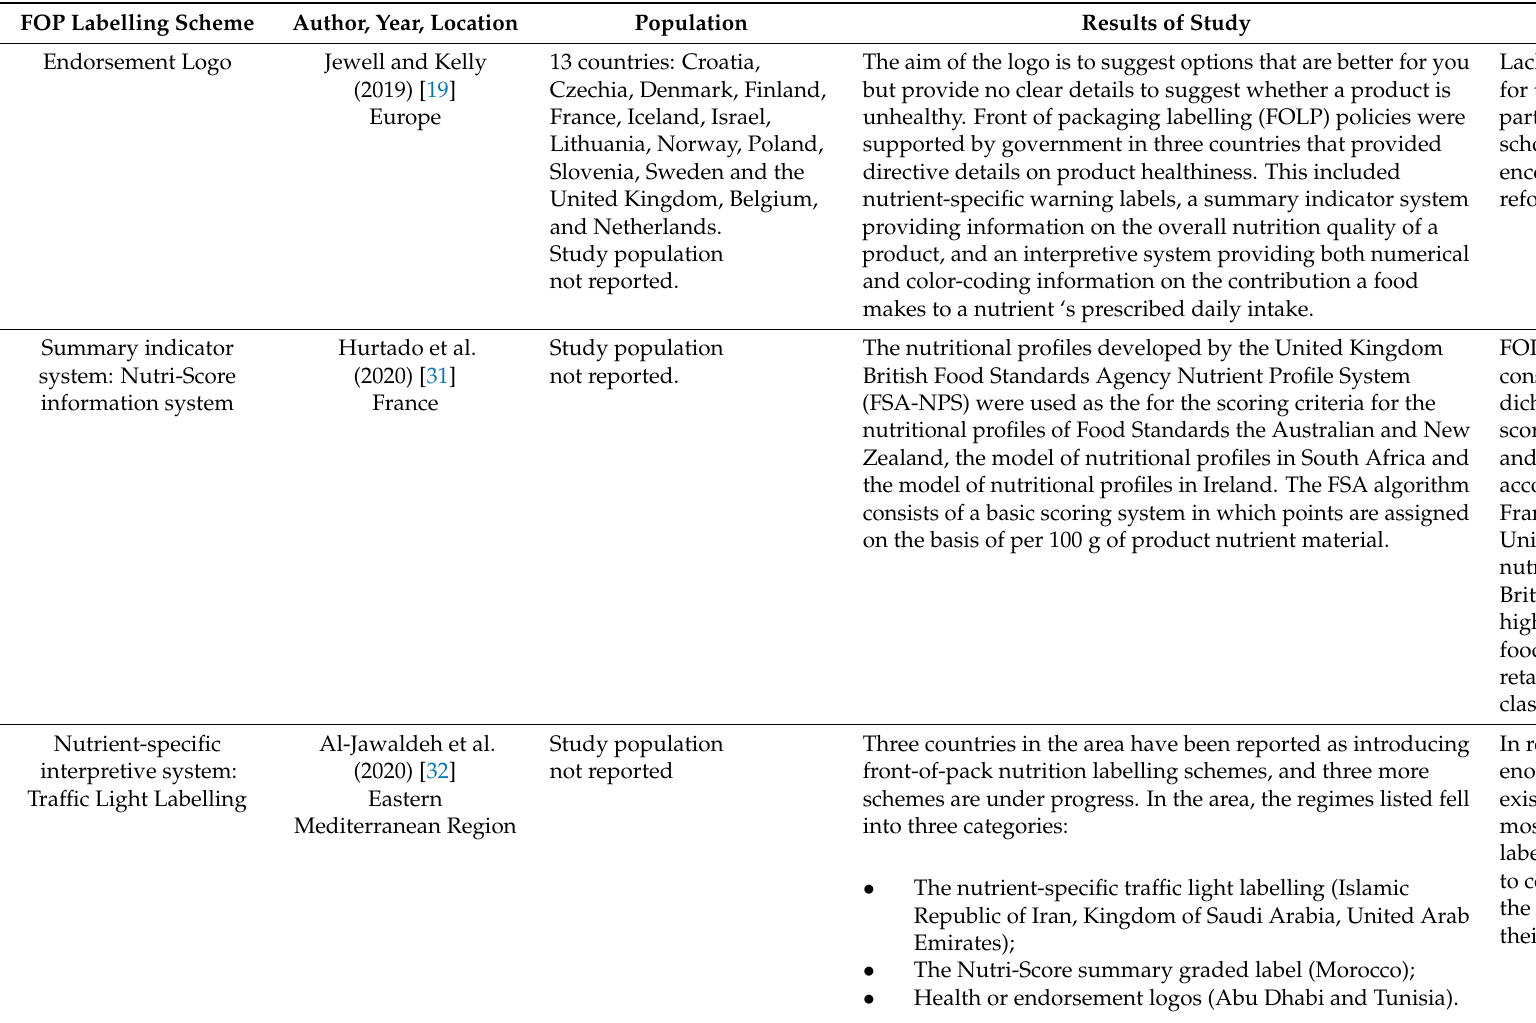
Table 2. Review on FOP labelling scheme studies to categorize food by relative